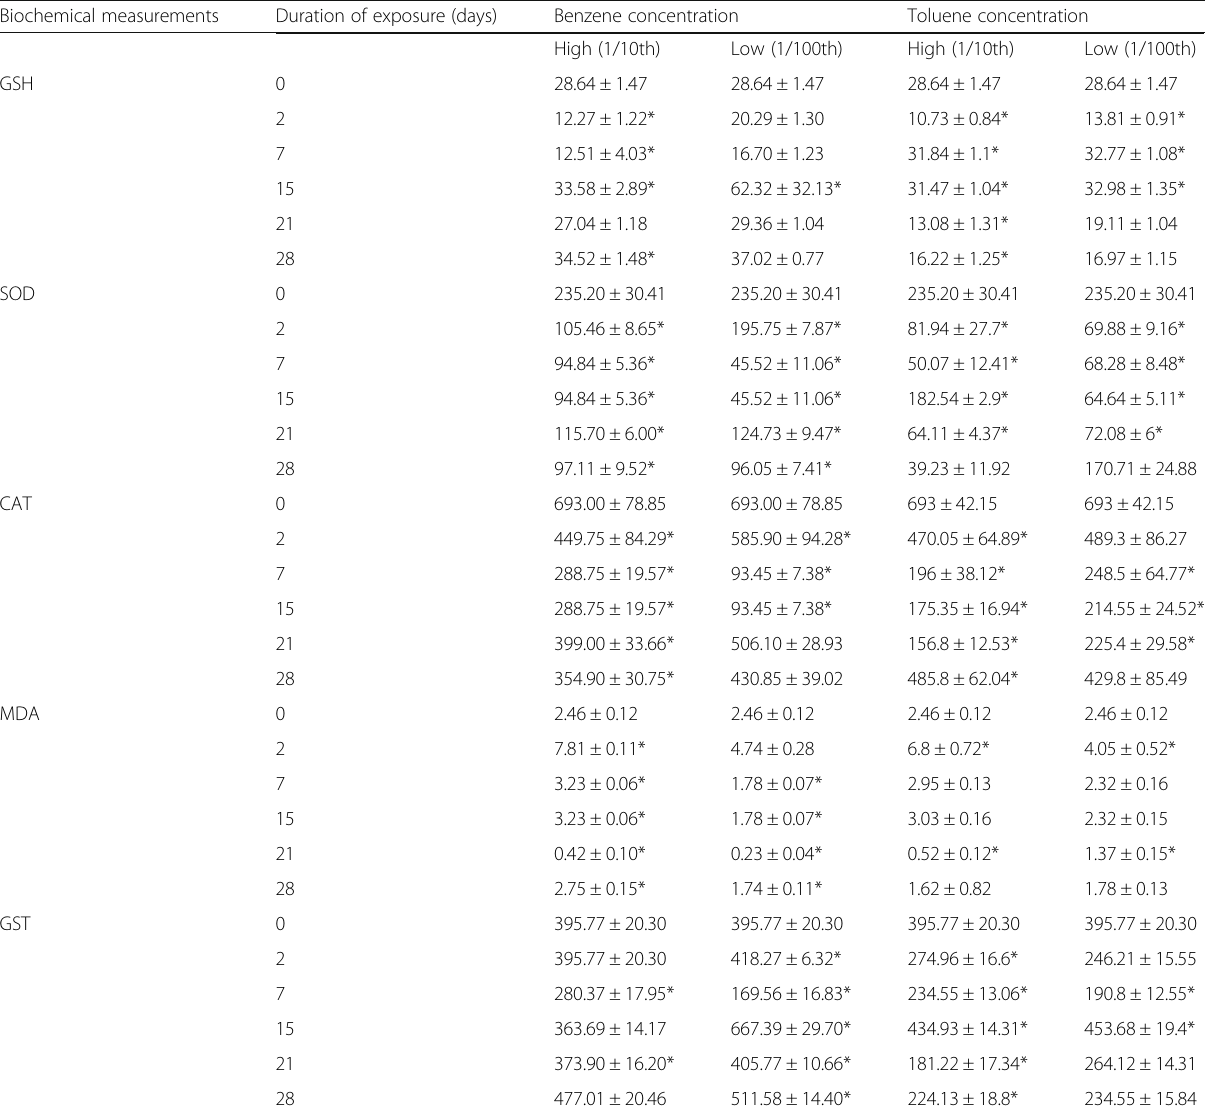
Table 3 Biochemical responses of E. eugeniae exposed to benzene and toluene contaminated soil Biochemical